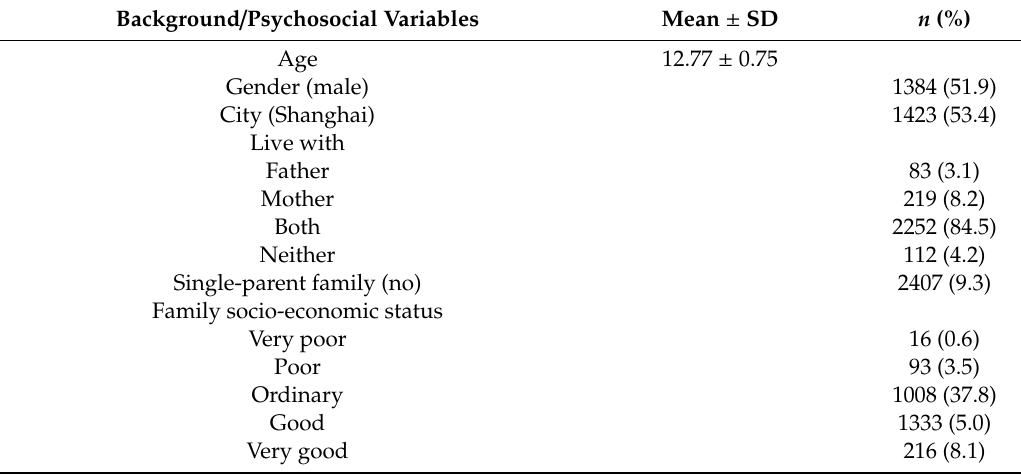
Table 1. Background characteristics the participants and mean scores of the psychosocial scales (N =